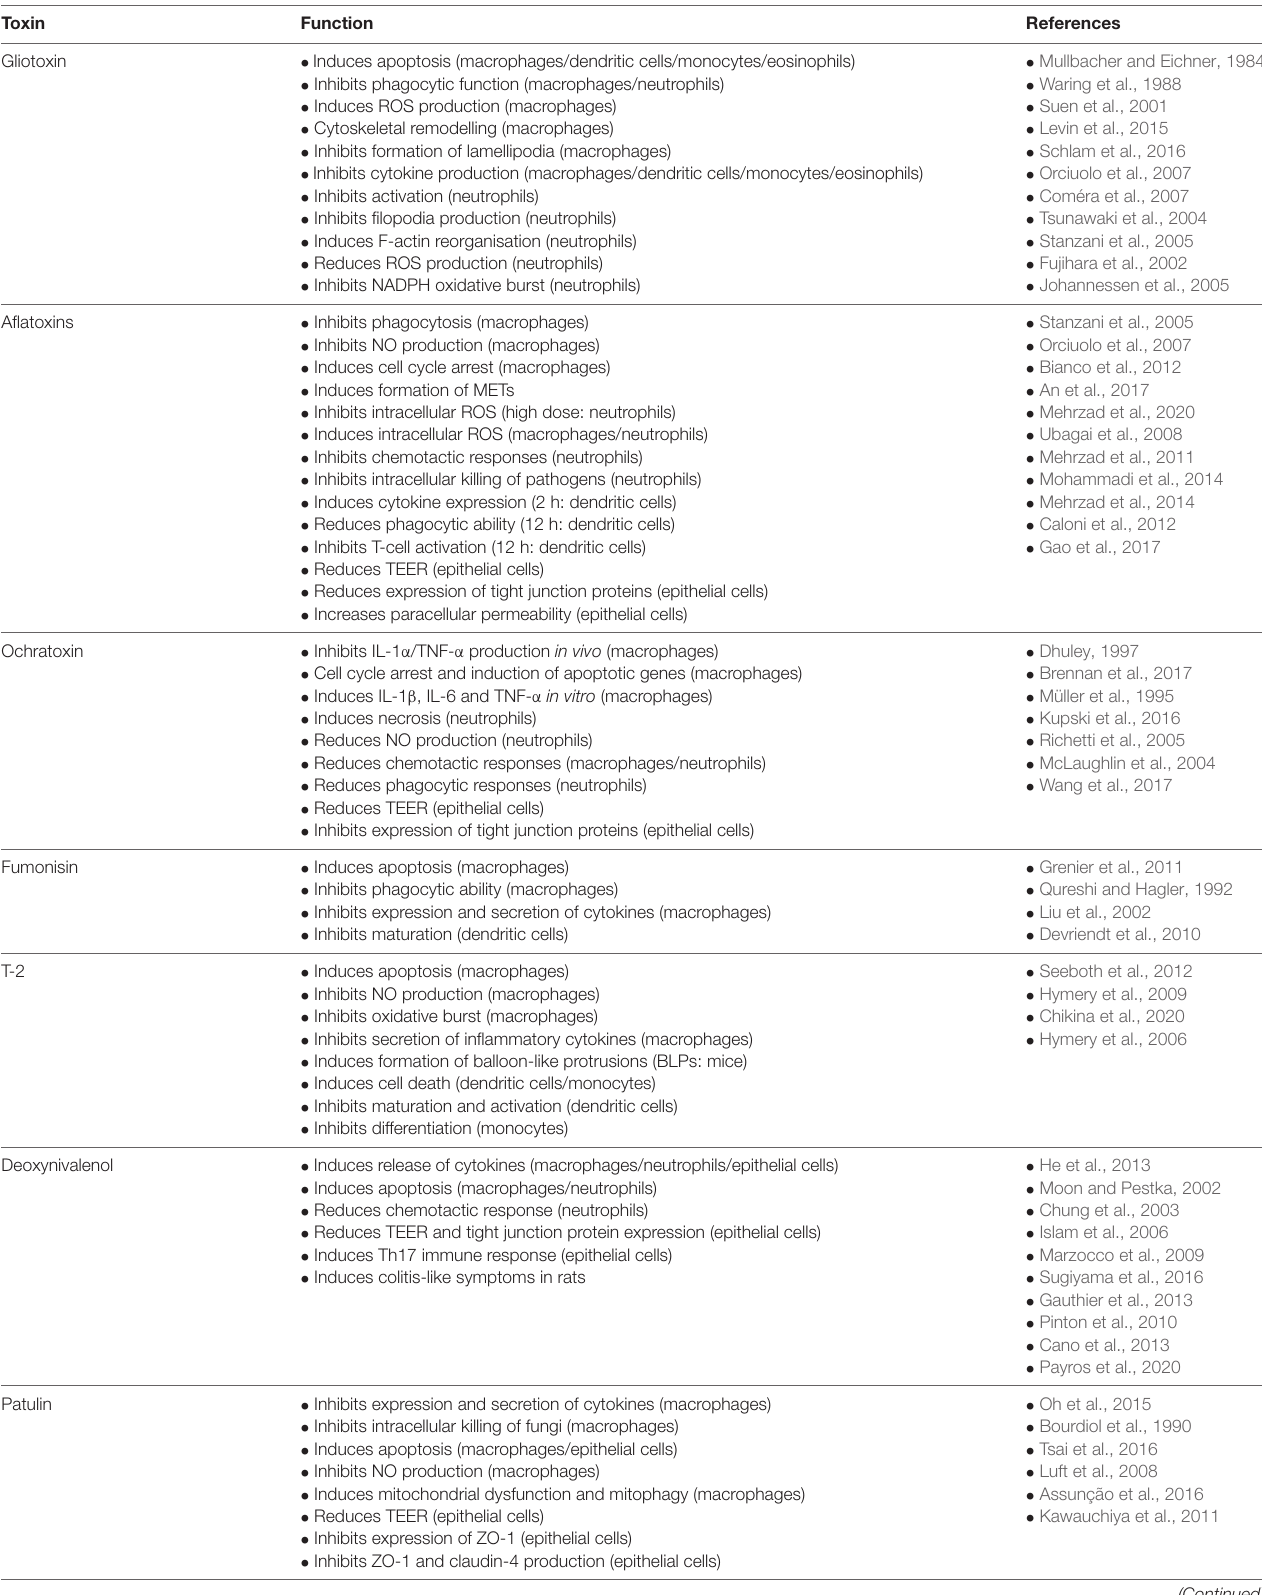
TABLE 1 | Modulation of host defences by mycotoxins, peptide, and protein toxins.